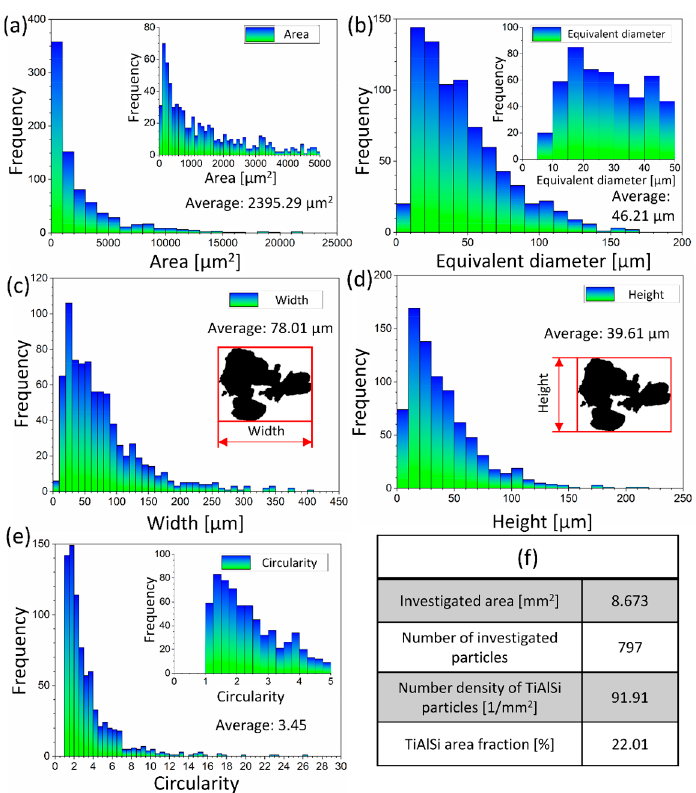
Figure A2. ( a – f ) Results of the image analysis of TiAlSi particles in the A2 sample.